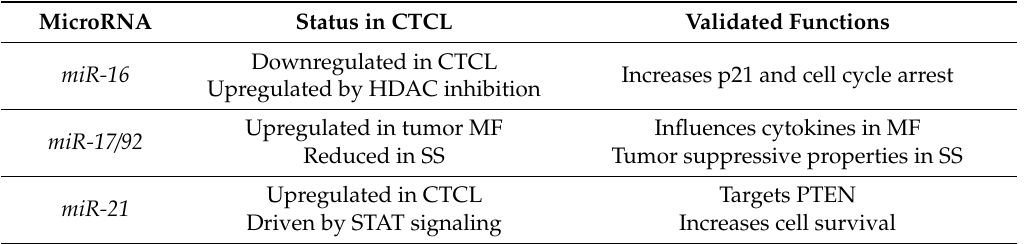
Table 2. Roles of miRs in CTCL